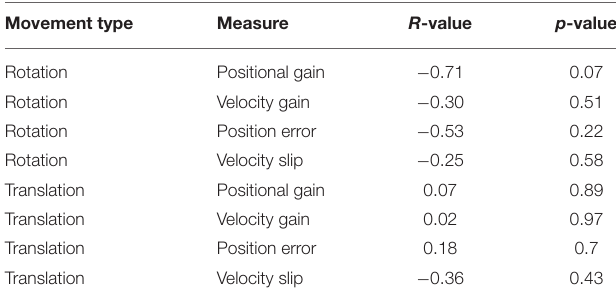
TABLE 2 | Statistical testing of correlations between DVA and positional gain, velocity gain, position error, and velocity